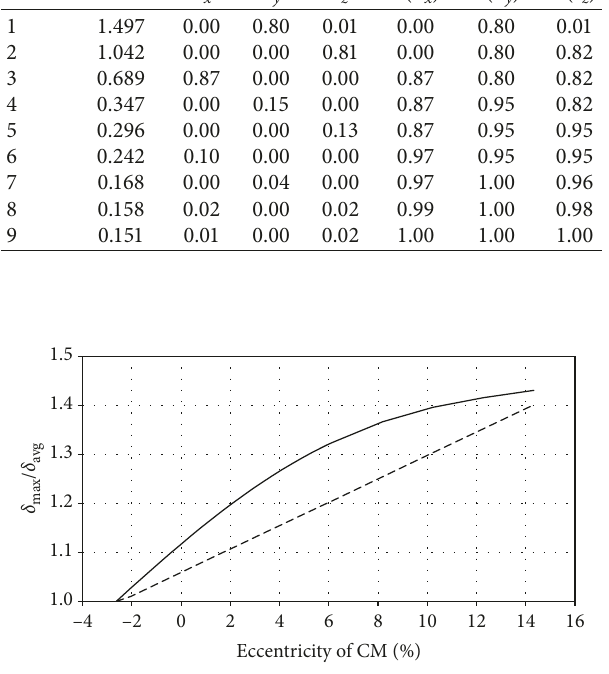
Figure 8: Ratios between maximum δ max and average displacement δ avg , at varying CM position. Comparison between linear dynamic analysis (continuous line) and linear static analysis (dotted line). The position of CM is given in % of the building longitudinal dimension ( L 48.85m); for e 0%, CM is in the actual position. (cid:31) (cid:31)